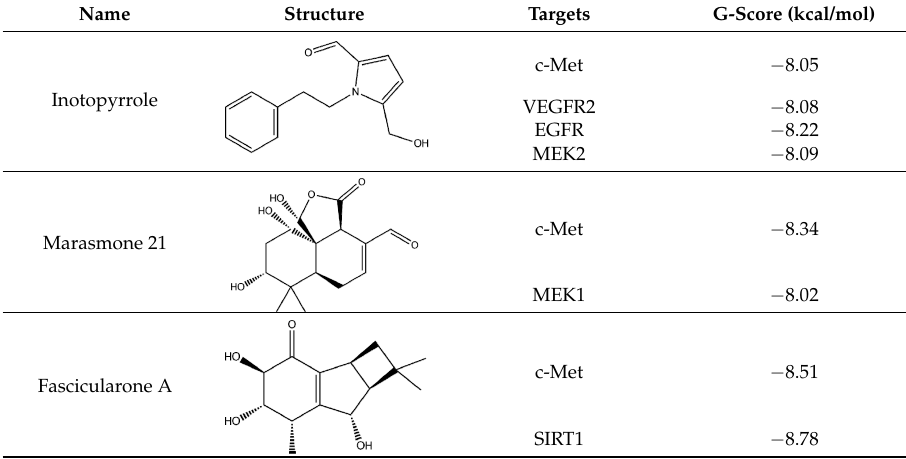
Table 1. Fungal components with best theoretical affinities (G-score) against multi-anticancer targets.